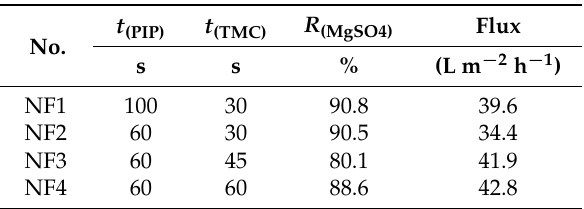
Table 4. Effect of monomer reaction time ( t ) on the retention ( R ) and solute flux of composite MCM; aqueous amine solution: 0.4 wt % PIP, 0.15 wt % TEA; organic solution: 0.15 wt %